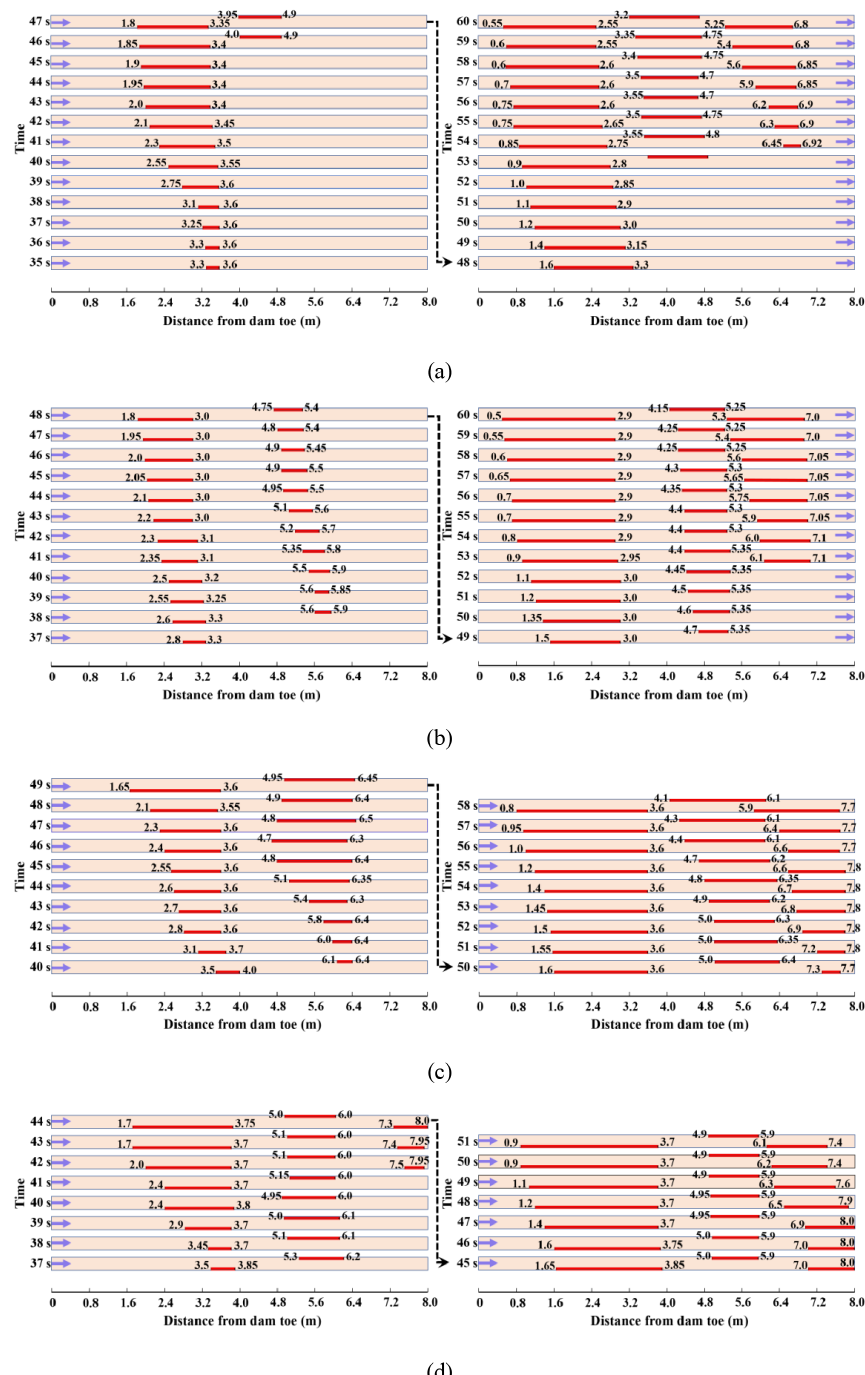
Earth Surf. Dynam., 9, 1263–1277, 2021